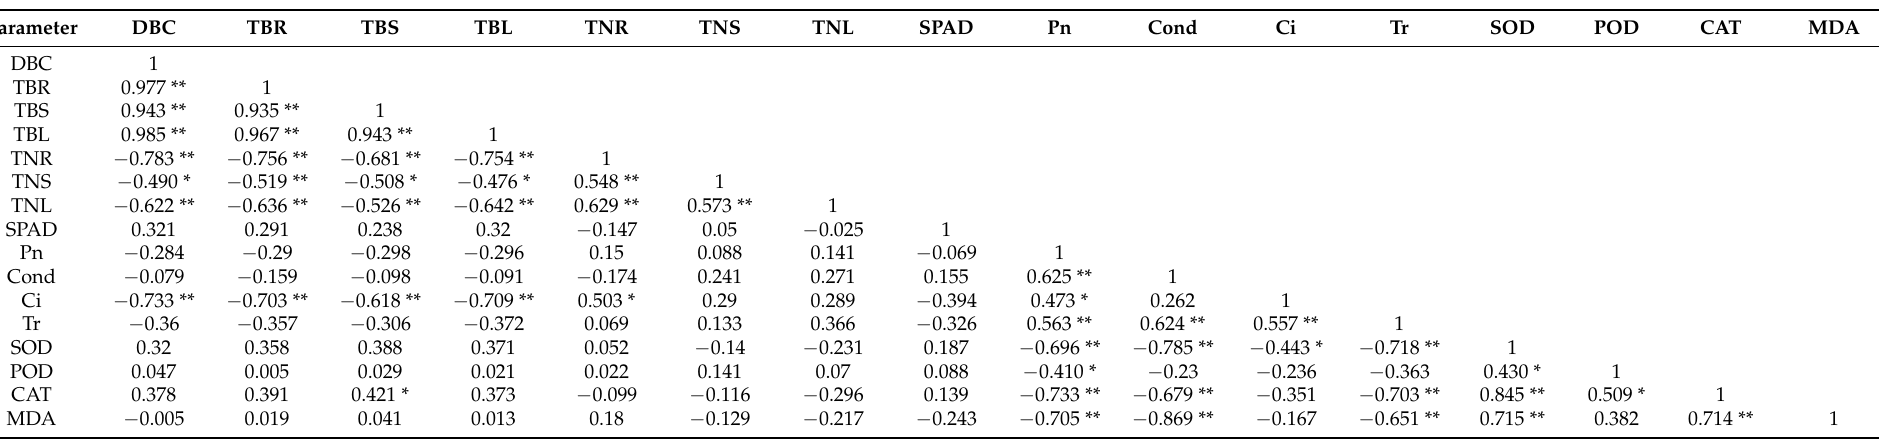
Table 3. Spearman correlation coefficients for correlations among different B concentrations and the tobacco seedlings growth